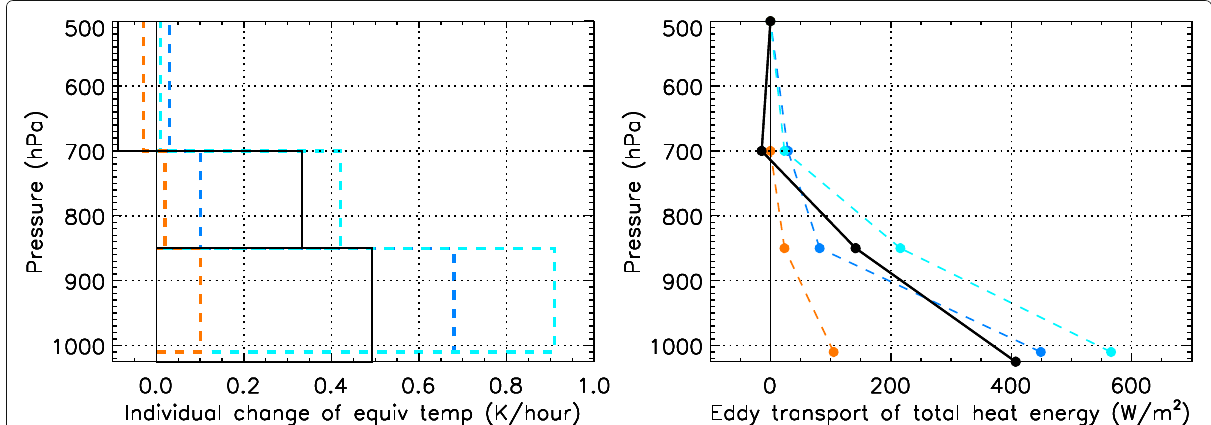
Fig. 6 Vertical profiles of results from R/V Hakuho-maru and AMTEX ‘74 observations. (Left) Individual change in the equivalent temperature. (Right) Eddy transport of the total heat energy. The results of the R/V Hakuho-maru observations are plotted with solid black lines. The results from AMTEX ‘74 are plotted with dashed lines: (blue) the results over the north area during the cold period, (light blue) the results over the south area during the cold period, and (orange) the results during the warm